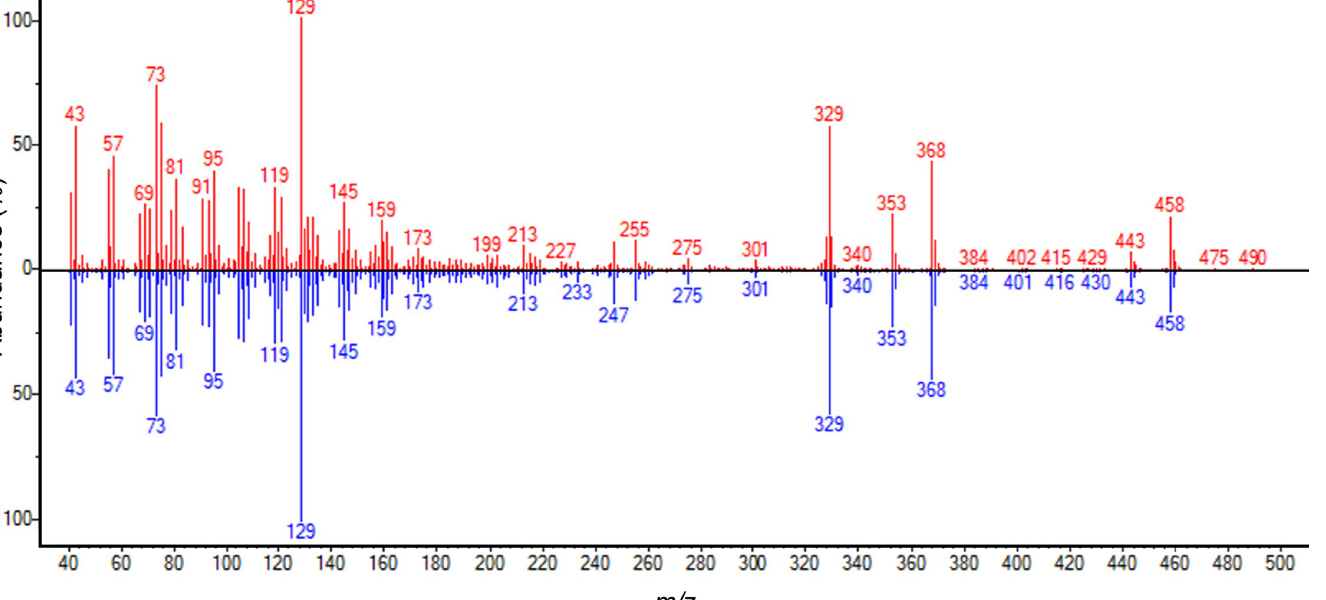
PLOS ONE | https://doi.org/10.1371/journal.pone.0268179 May 19,